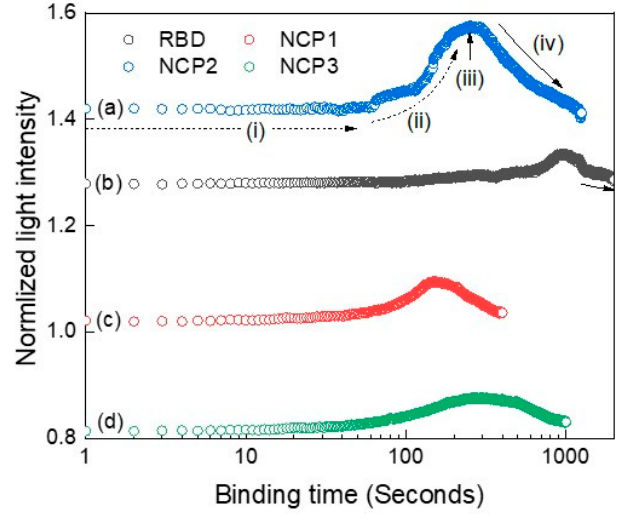
Figure 9. Optical profiles for normalized interactions vs. binding time under different conditions for RBD and NCP. ( a ) NCP with its antibody at the maximum concentration of 22 µ g per mL; ( b ) RBD with its antibody; ( c ) NCP with its antibody at a 1:10 dilution; ( d ) NCP with its antibody at 1:10 with outside mixing.